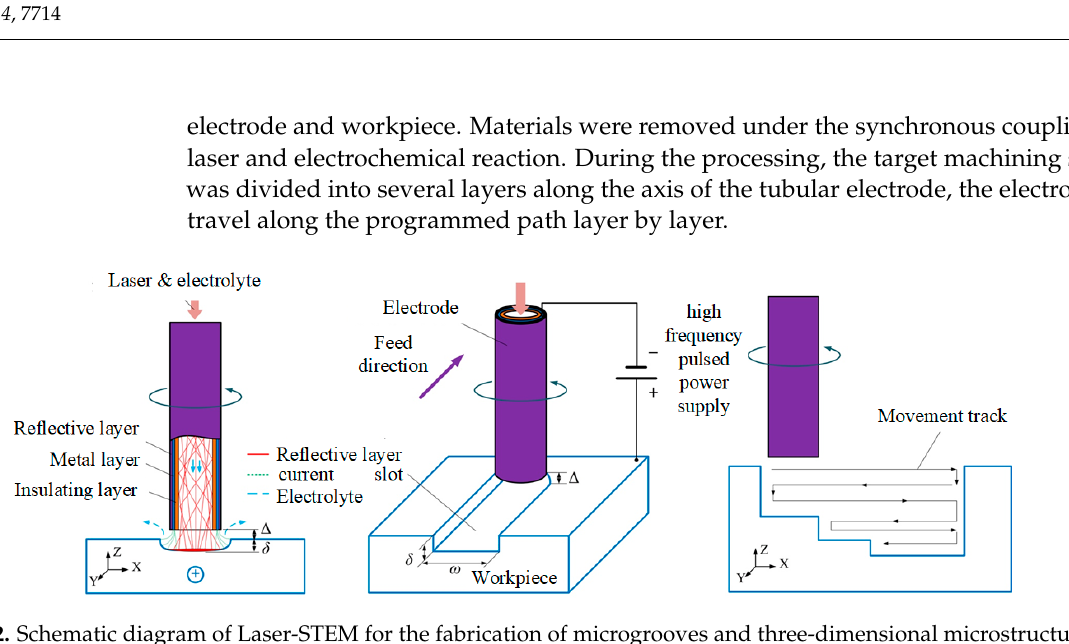
Figure 2. Schematic diagram of Laser-STEM for the fabrication of microgrooves and three-dimensional microstructures.